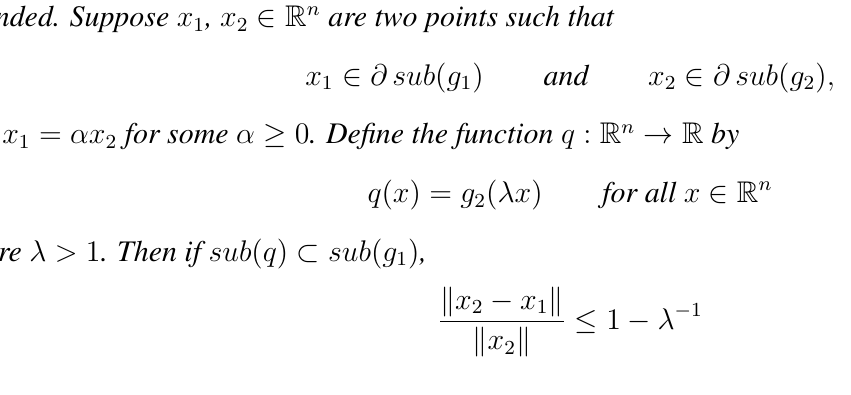
Figure 2. Example of stopping conditions. Curve 1 is the inner set and curve 2 is the outer set. Curve 3 is the shrunk set of the outer